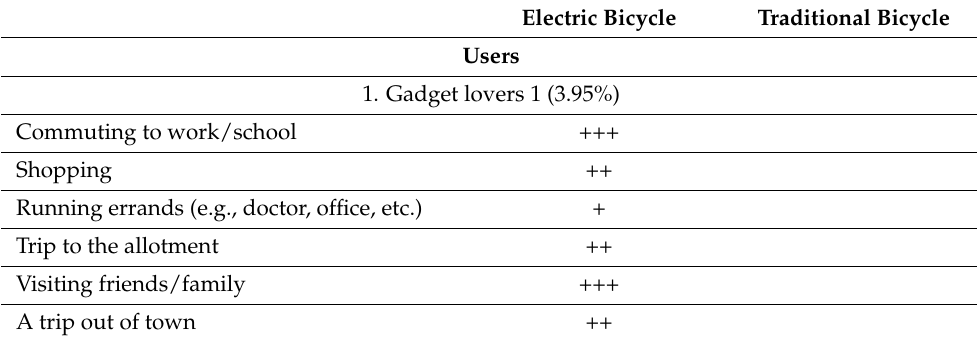
Table 4. The use of the traditional and electric bicycle among all proposed